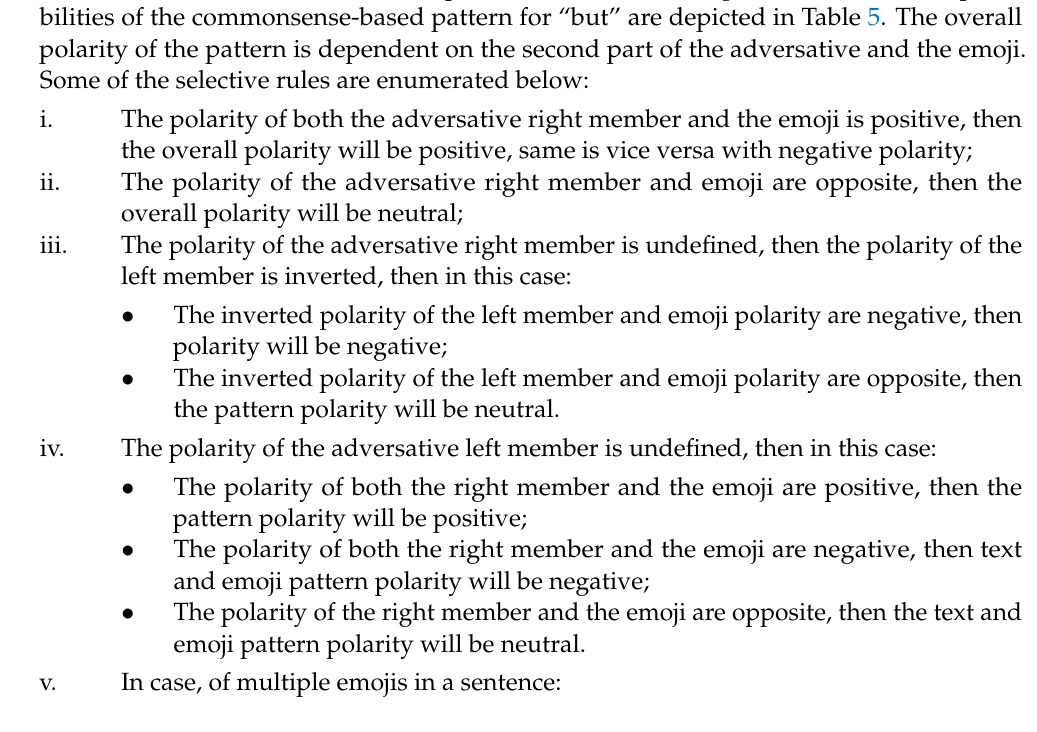
Table 5. But and adversatives